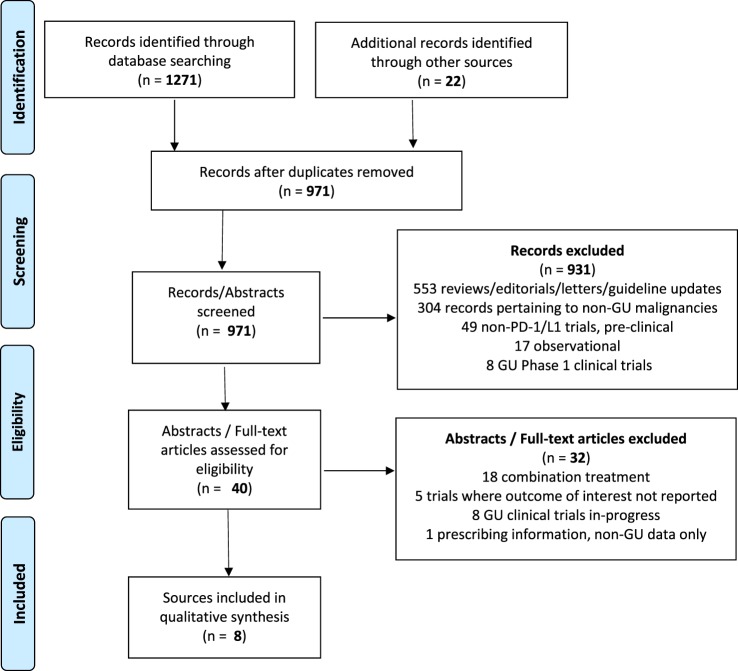
Data selection process (18).